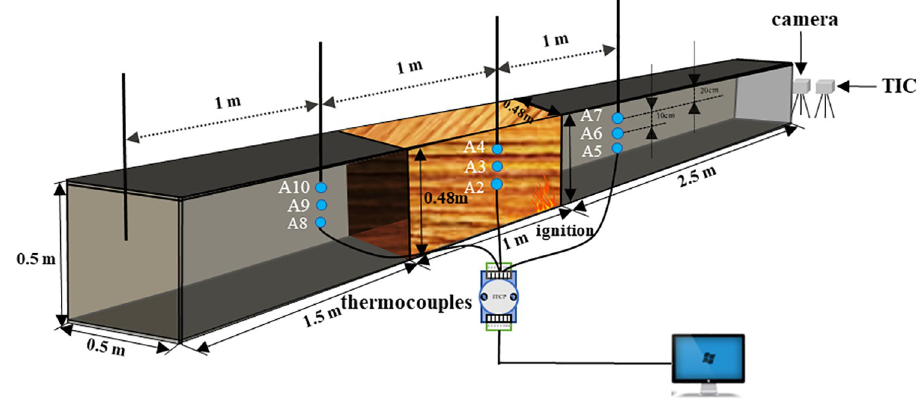
Fig 1. Schematic of tunnel